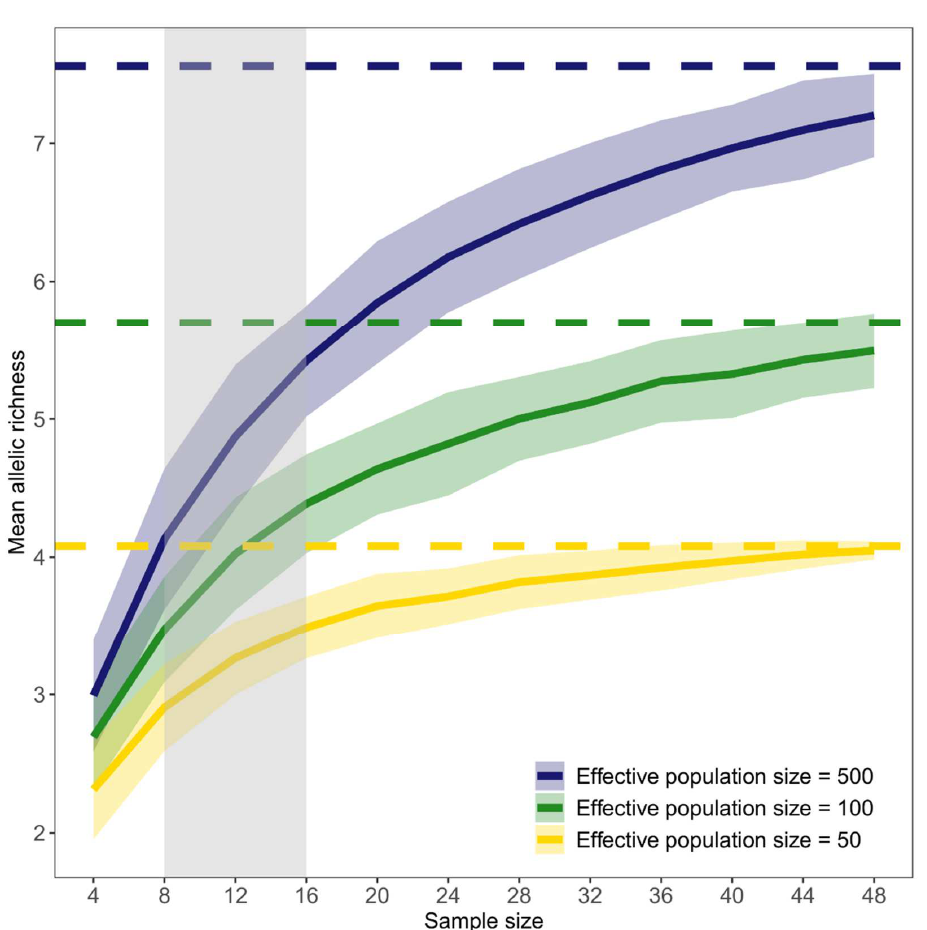
Figure 2. Effect of increasing sample size on genetic diversity for different effective population sizes. Solid lines represent the mean allelic richness and shaded areas around each line outline 95% confidence intervals, estimated on 100 resampled datasets for each sample size. Dashed lines represent mean allelic richness assessed over a sample size of 50 individuals. The gray-shaded area encompasses the sample size interval of the real data.